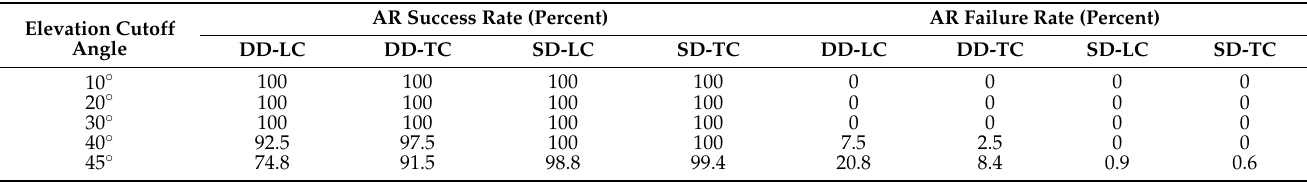
Table 8. The AR success and failure rates of the DD-LC, DD-TC, SD-LC, and SD-TC models under different elevation cutoff angles in the multi-epoch solution.